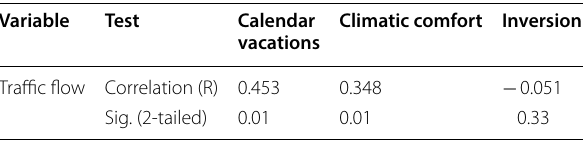
Table 6 Correlation test between variables based on daily summarized data (N =